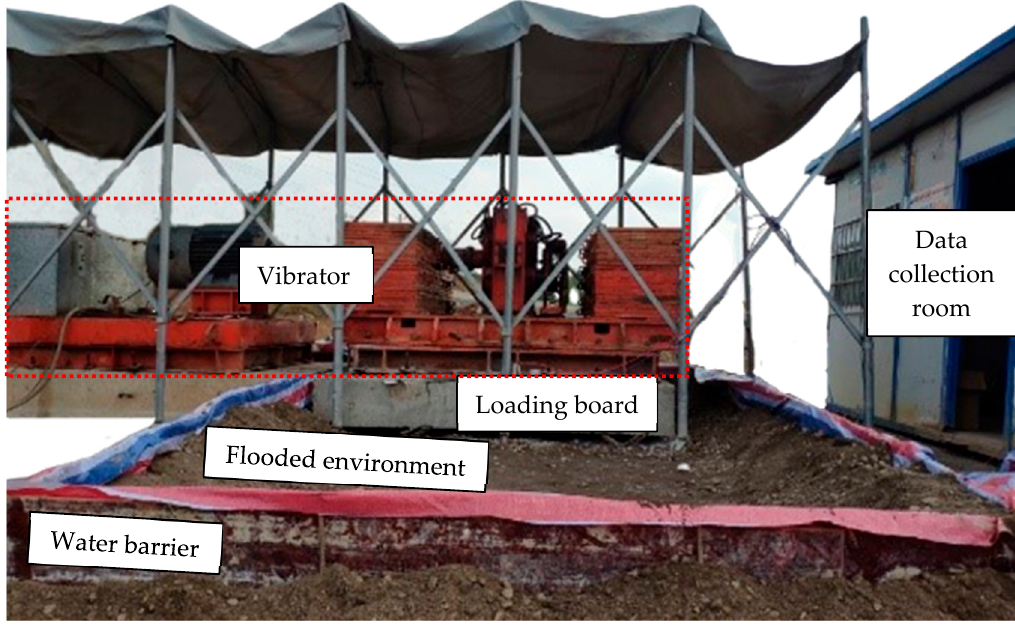
Figure 7. Excitation test equipment and simulation of water immersion conditions.